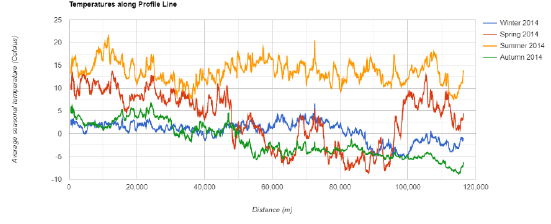
Figure 5: Stuttgart mean temperature per